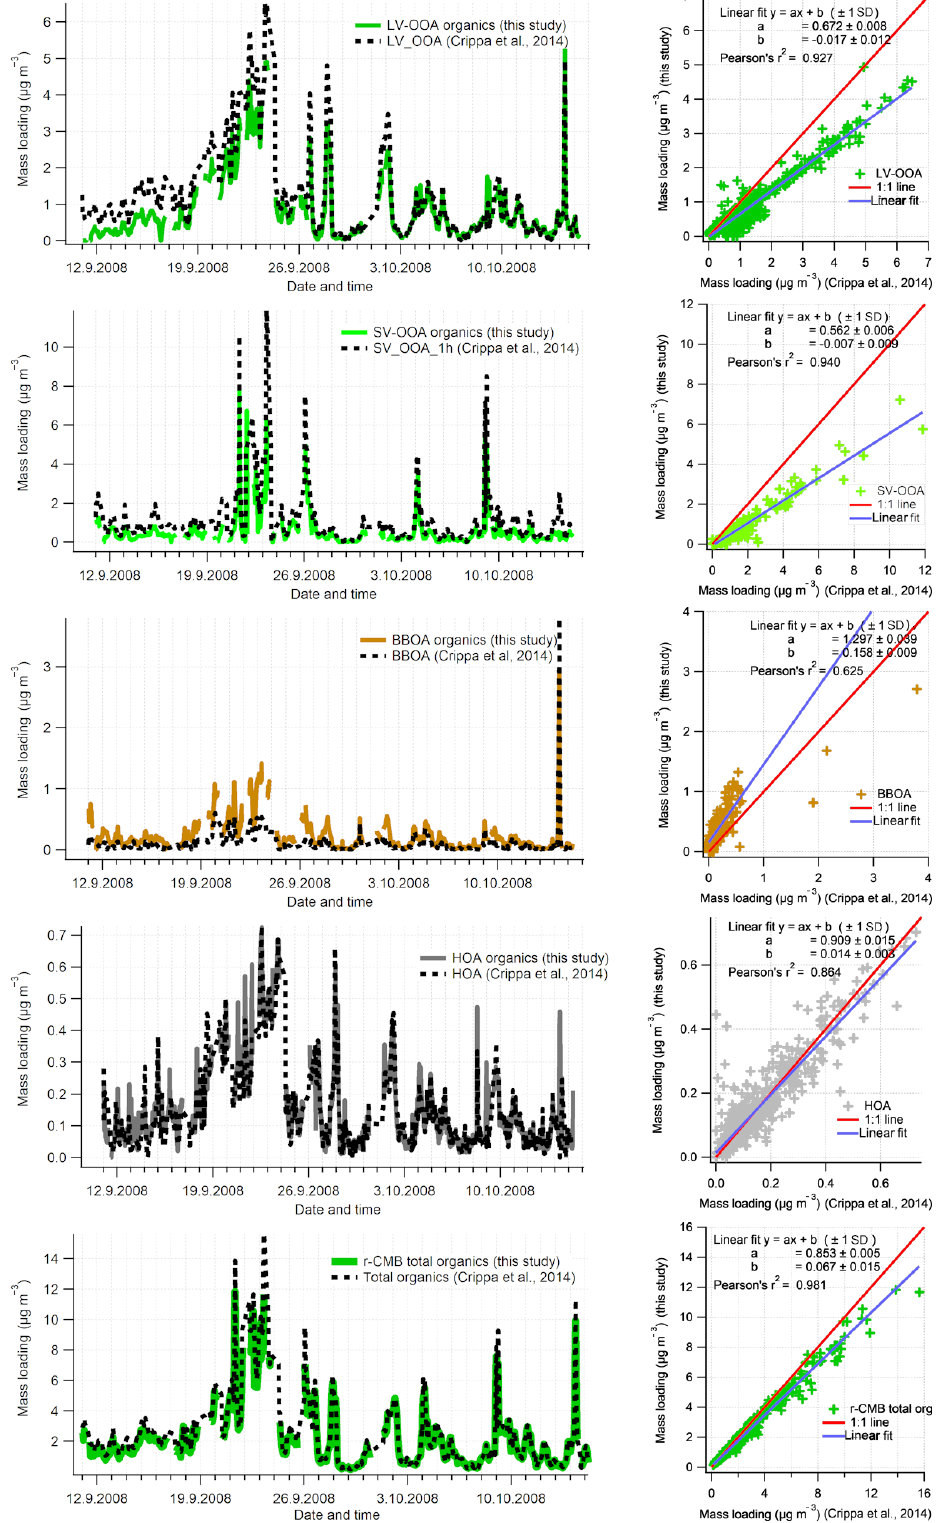
Figure 8. Time series comparison of aerosol organic component with Crippa et al. (2014) for the September 2008 campaign (data set II). For comparability, only the organic part of r-CMB model components are considered. Data from this work have been averaged to 1h resolution. Organics in other r-CMB components (AS, AN, ON) are taken into account for the total amount but not shown separately. Discrepancy in total organics loading is due to differences in pre-processing values (e.g. ionisation efficiency, collection efficiency).